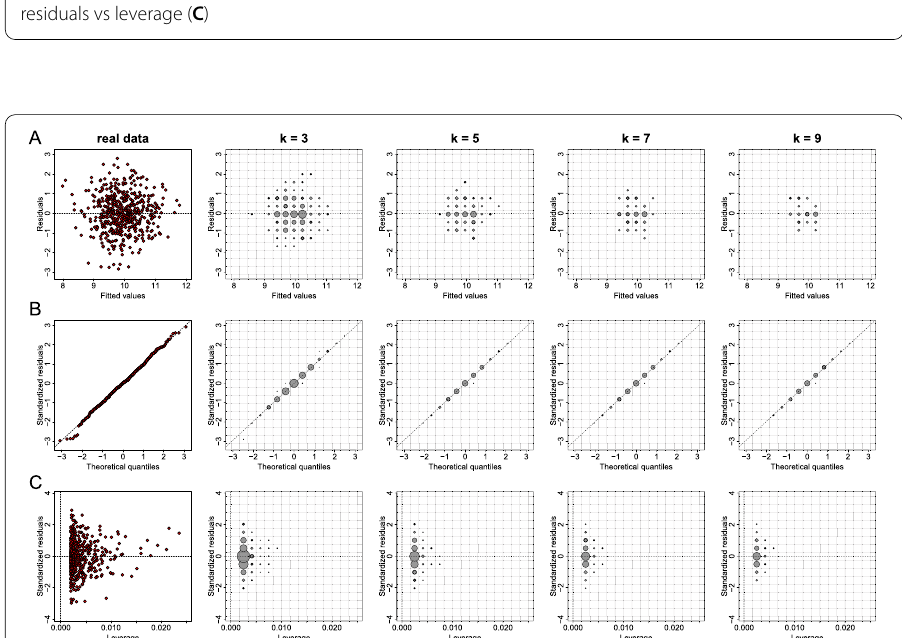
Figure 11 The effect of parameter k of the k -anonymization method on regression plot diagnostics with additional generalization. From left to right we demonstrate the effect of k for the values of 1 (this is equivalent to the real data), 3, 5, 7 and 9 on generating privacy-preserving residuals vs fitted values plots ( A ), normal QQ plots ( B ), and standardized residuals vs leverage ( C )